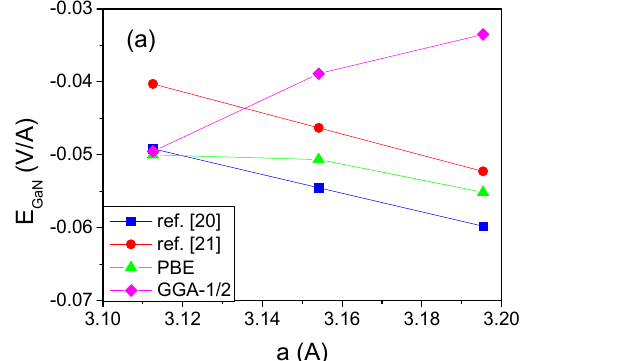
Figure 4. Double averaged electric potential profiles, obtained for 8AlN-8GaN atomic layers superlat- tice. The line represents: AlN—structure strained to AlN, a lattice constant; FS—freestanding lattice; GaN—structure strained to GaN, a lattice constant.